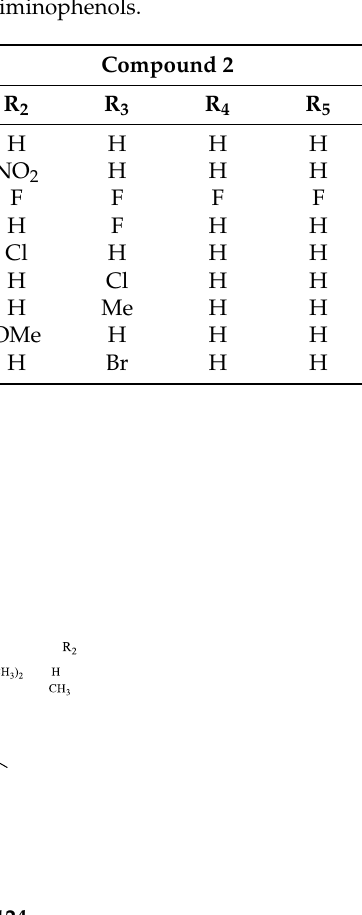
Table 1. Table for preparation of various salicylideniminophenols.